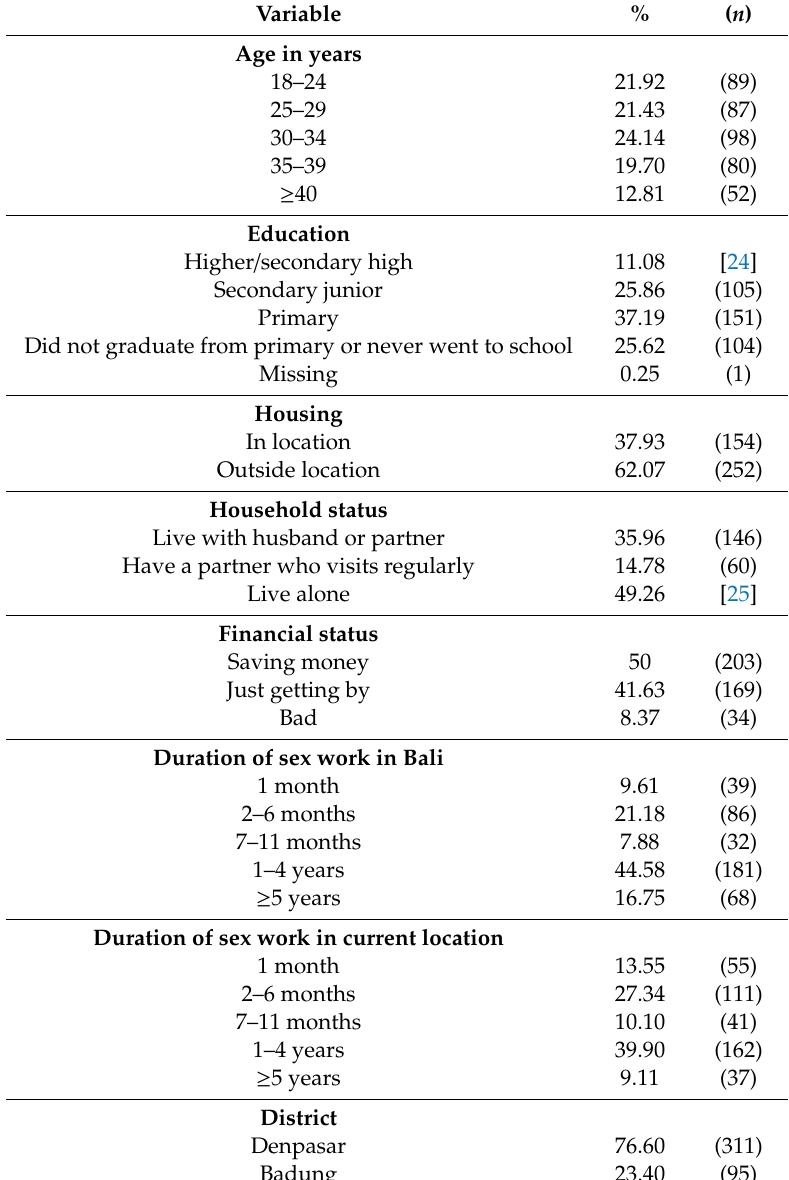
Table 2. Socio-demographic characteristics of direct